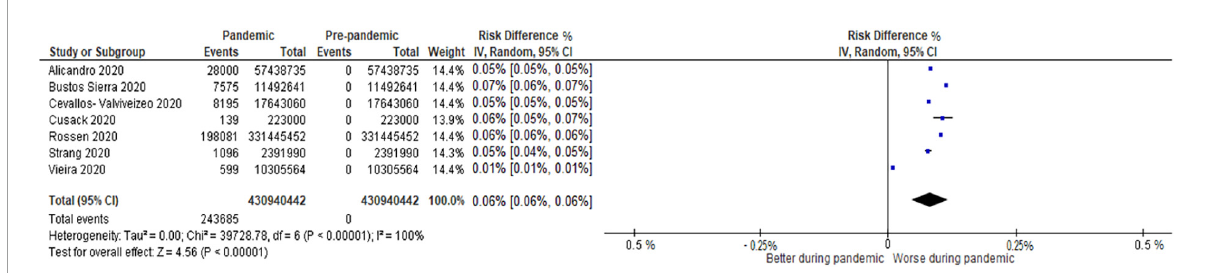
FIGURE2 Forest plot for COVID-19 mortality. CI, confidence intervals; COVID-19, coronavirus disease 2019; IV, inverse variance.